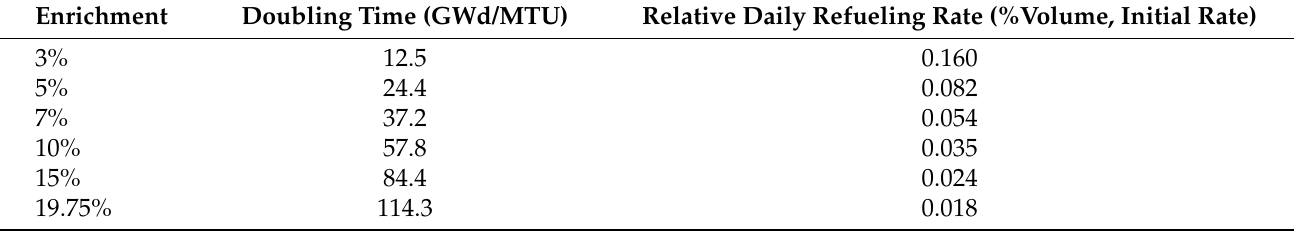
Table 1. Doubling times for various makeup fuel enrichments with corresponding initial daily refueling rates.